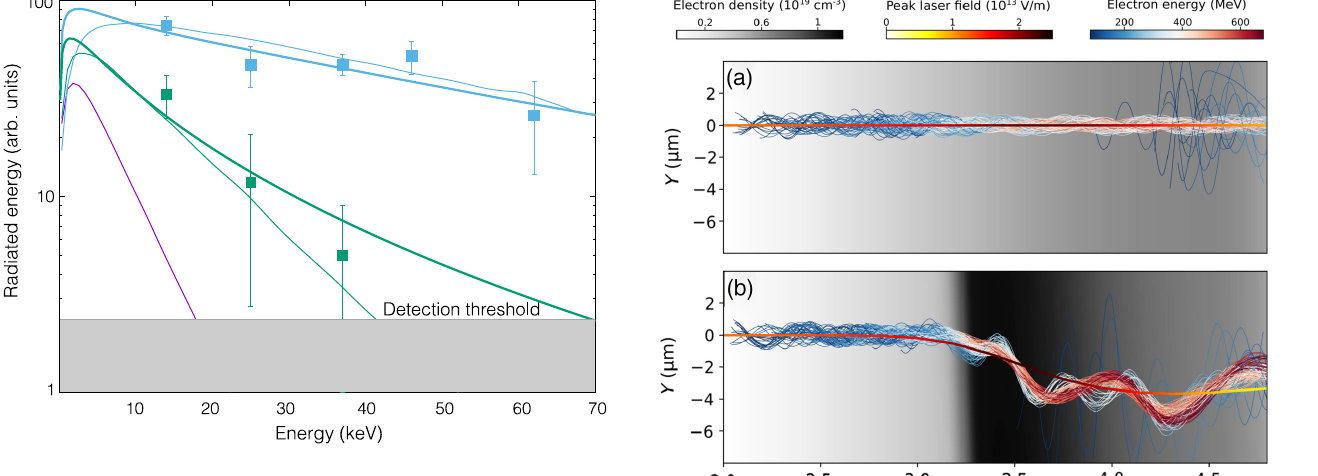
FIG. 5. Betatron radiation spectra measured for the constant density (purple), longitudinal gradient (green), and combined longitudinal and transverse gradients (blue). Thin and thick lines respectively correspond to the test-particle and particle-in-cell simulations. As expected, the increase of γ and r β deduced from Fig. 4 results in a shift of the radiation spectrum toward higher energies. The critical energies shift from 5 to 10 and to 50 keV for, respectively, for the purple, green, and blue fits.